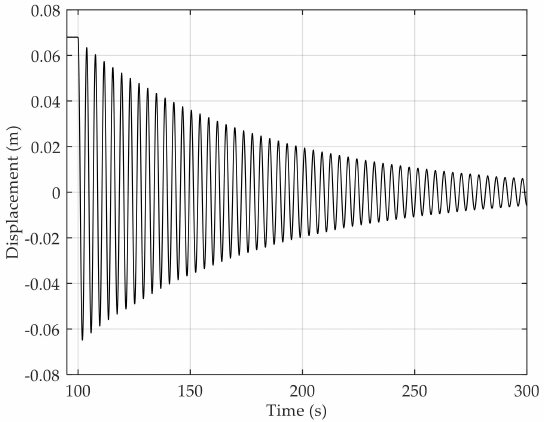
Figure 3. A decay curve of a floating structure in a specific degree of